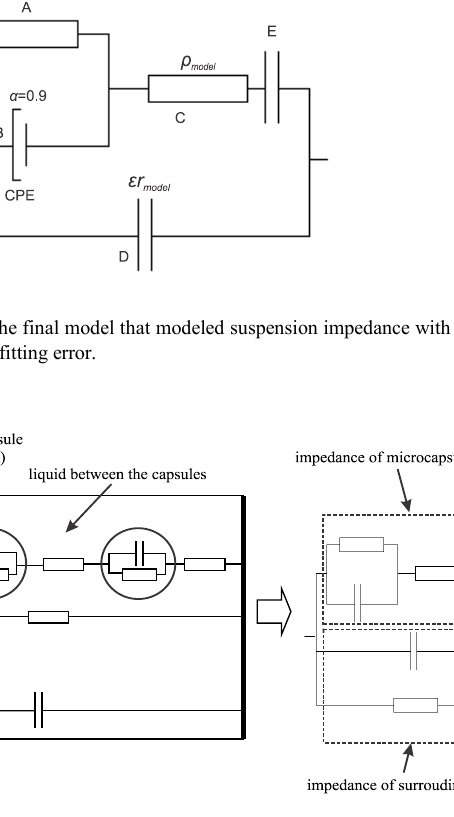
Fig. 9: The fitting between the physically based model and the measured impedance (specific complex resistivity) of a